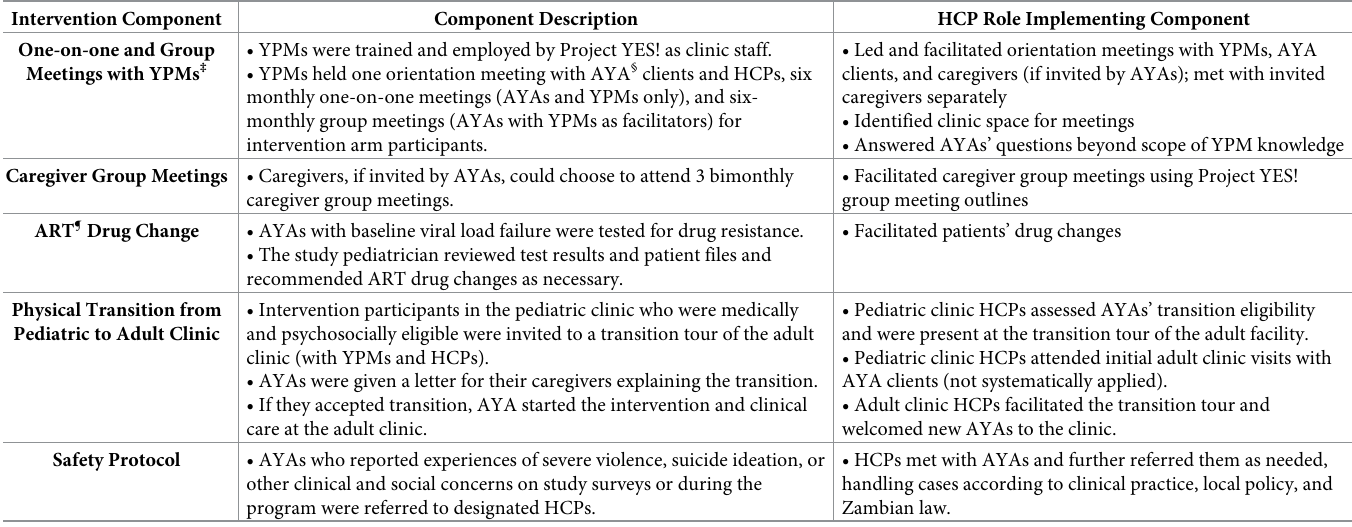
Table 1. Project YES! components and HCP † roles in component